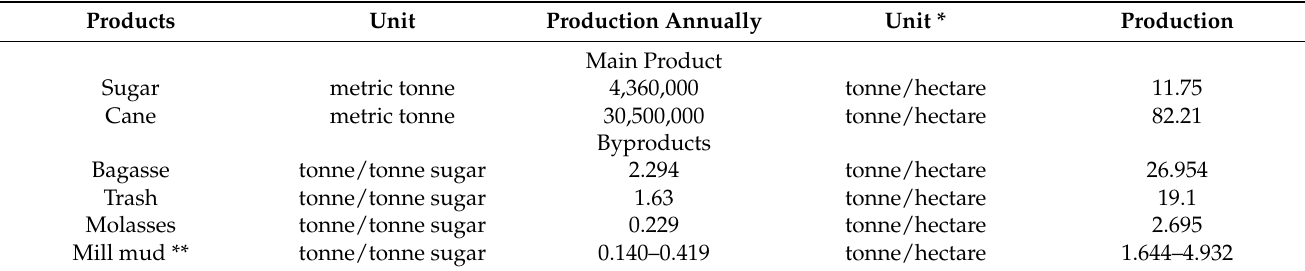
Table 1. Main product and byproducts of sugar cane mill.